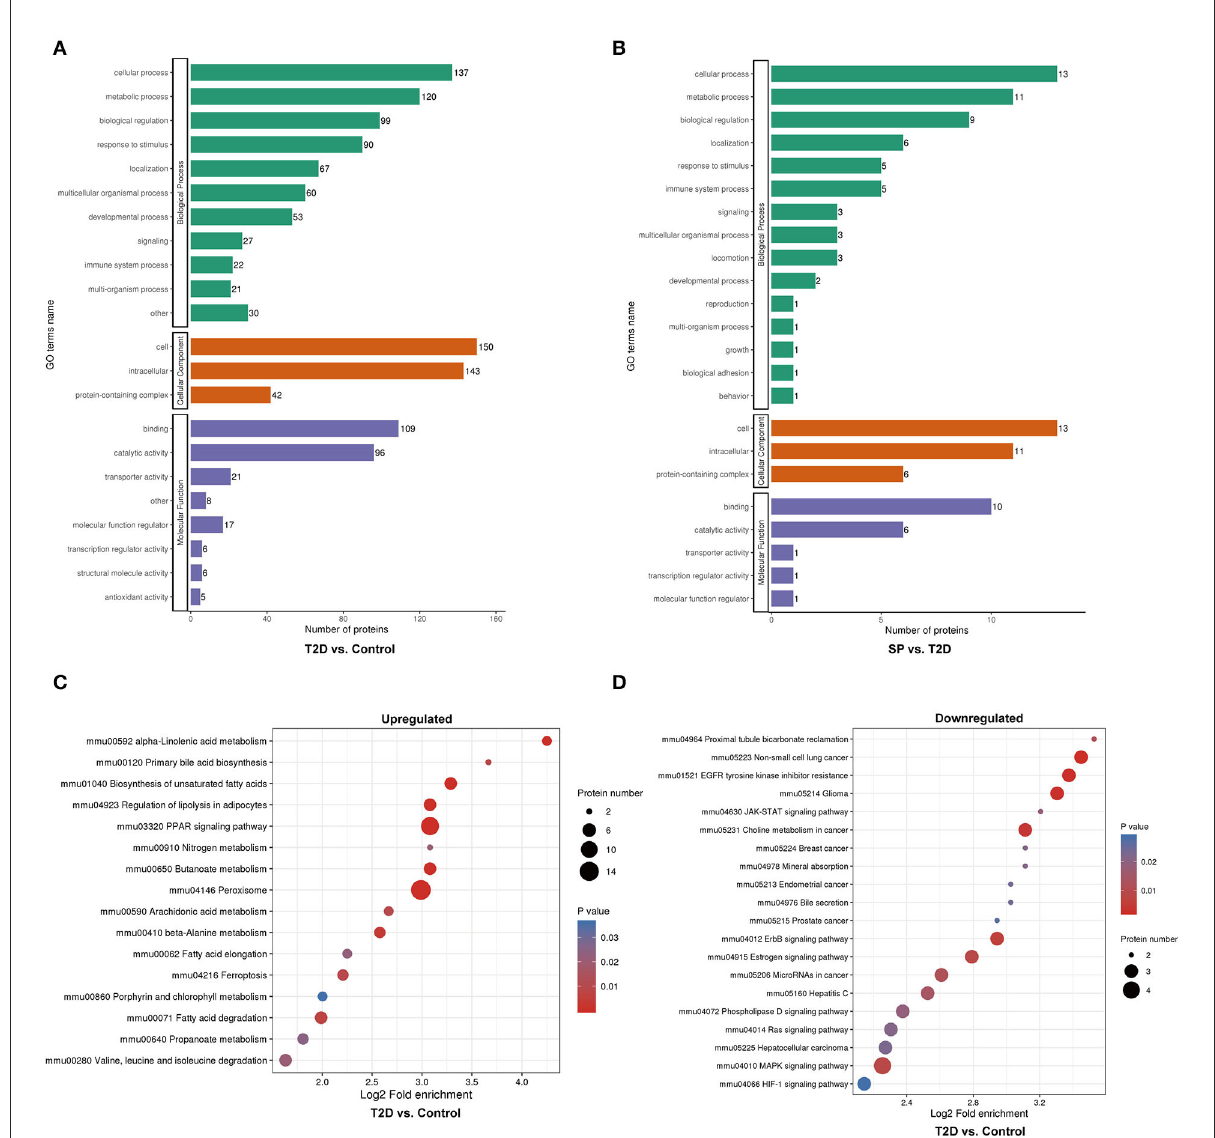
FIGURE4 Gene ontology (GO) analysis and Kyoto Encyclopedia of Genes and Genomes (KEGG) pathway enrichment analysis of the differentially expressed proteins (DEPs). (A) GO enrichment analysis of the DEPs between Control and T2D groups, (B) GO enrichment analysis of the DEPs between T2D and T2D + SP groups, (C) bubble diagrams representing the top 16 KEGG pathways where upregulated DEPs enriched, and (D) bubble diagrams representing the top 20 KEGG pathways where downregulated DEPs